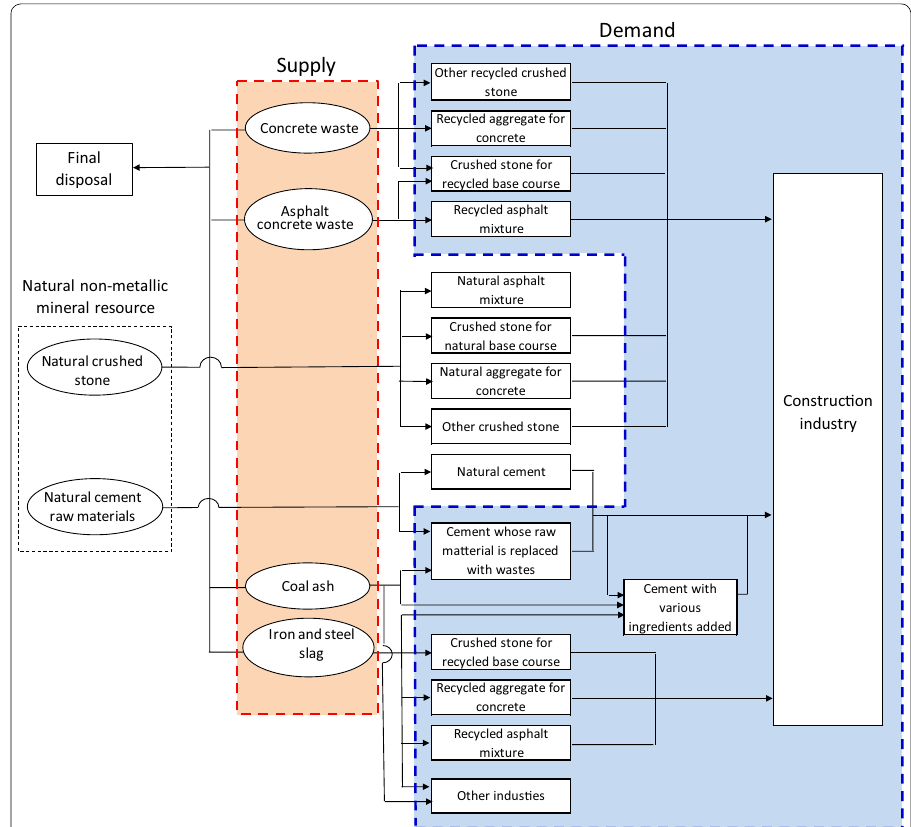
Fig. 1 Material flow in supply and demand for non-metallic mineral